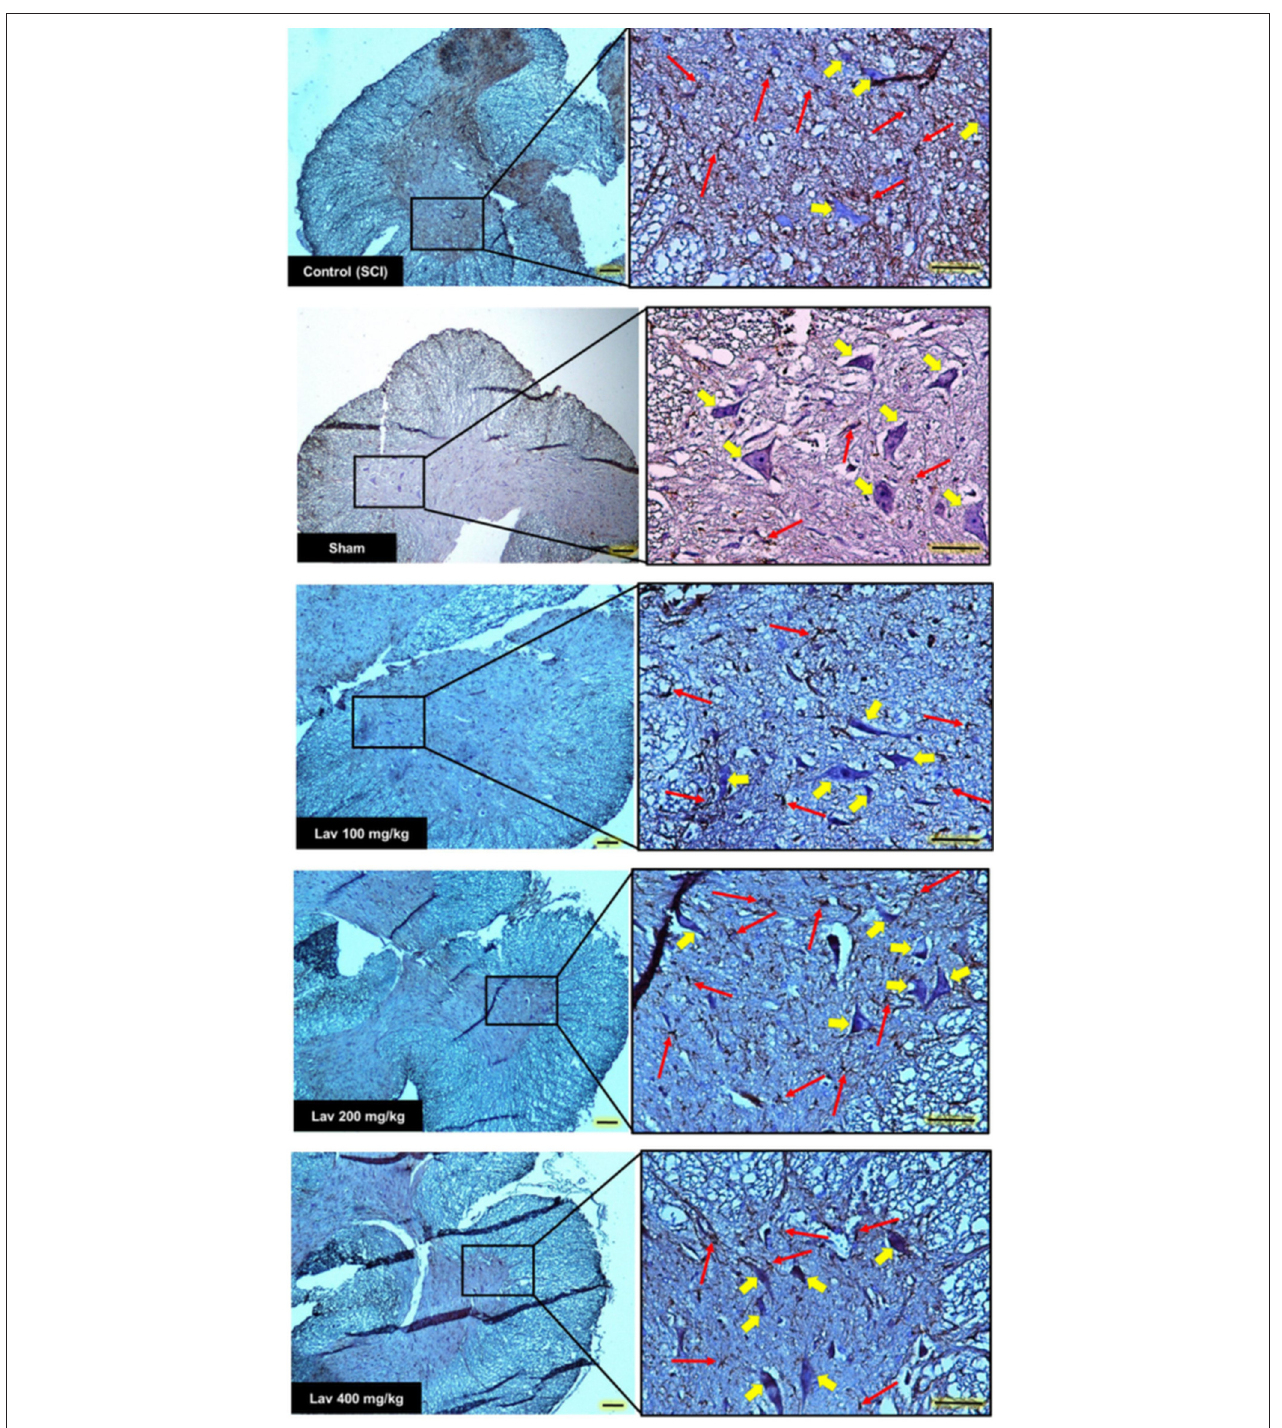
FIGURE 4 | Transverse section of spinal cord showing the ventral horn gray matter at the T12-L1 level for all groups on day 56 GFAP-stained images. Red arrows indicate the GFAP astrocytes. Yellow arrows indicate VHMNs. Decreased GFAP astrocytes and increased VHMNs are evident. Bar in 40X = 100 micrometer and Bar in 200X = 50 micrometer. (ECLIPSE 5Oi